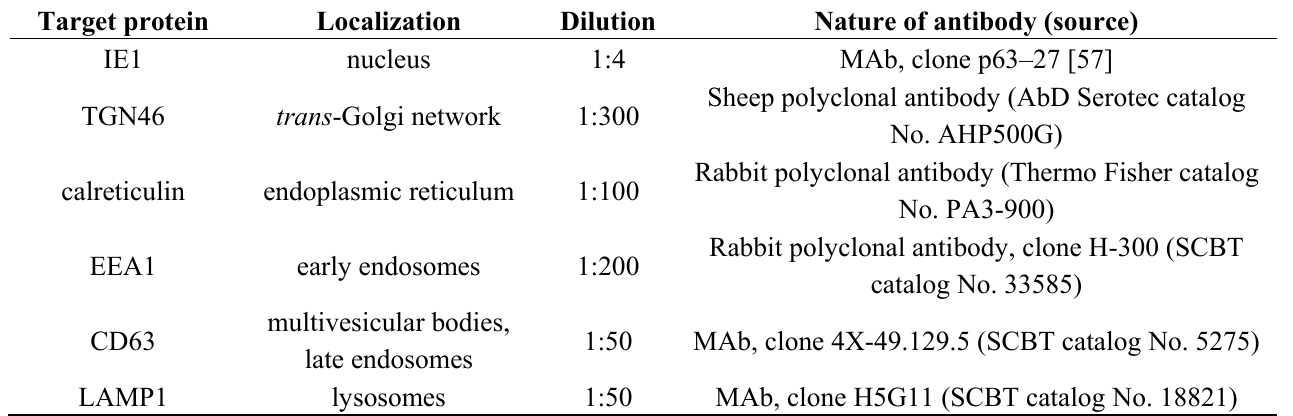
Table 2. Antibodies used in this